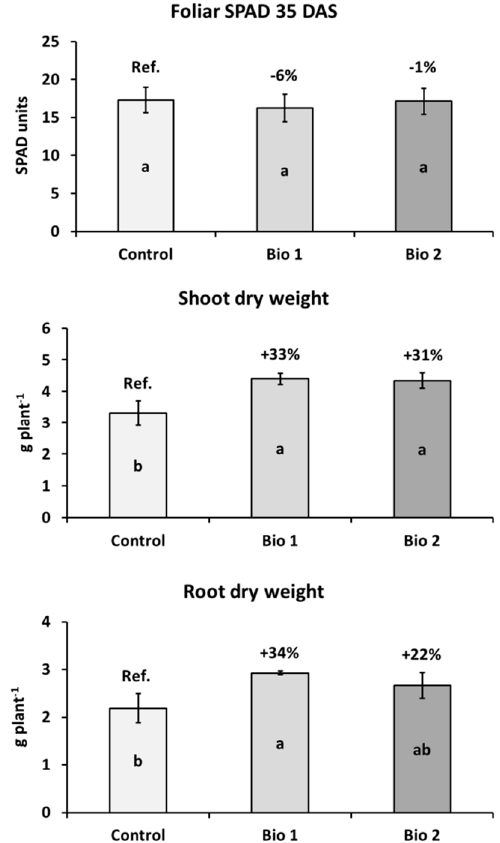
Figure 1. The leaf SPAD values, shoot and root dry biomass (mean ± S.E., n = 3) of pot-cultivated maize (4–5 leaf stage, 35 days after sowing) treated with two seed-coating biostimulants (Bio1 and Bio2) in comparison with untreated controls. Different letters (a,b) indicate significant differences between samples according to the Student Newman-Keuls method (SNK) (p ≤ 0.05).